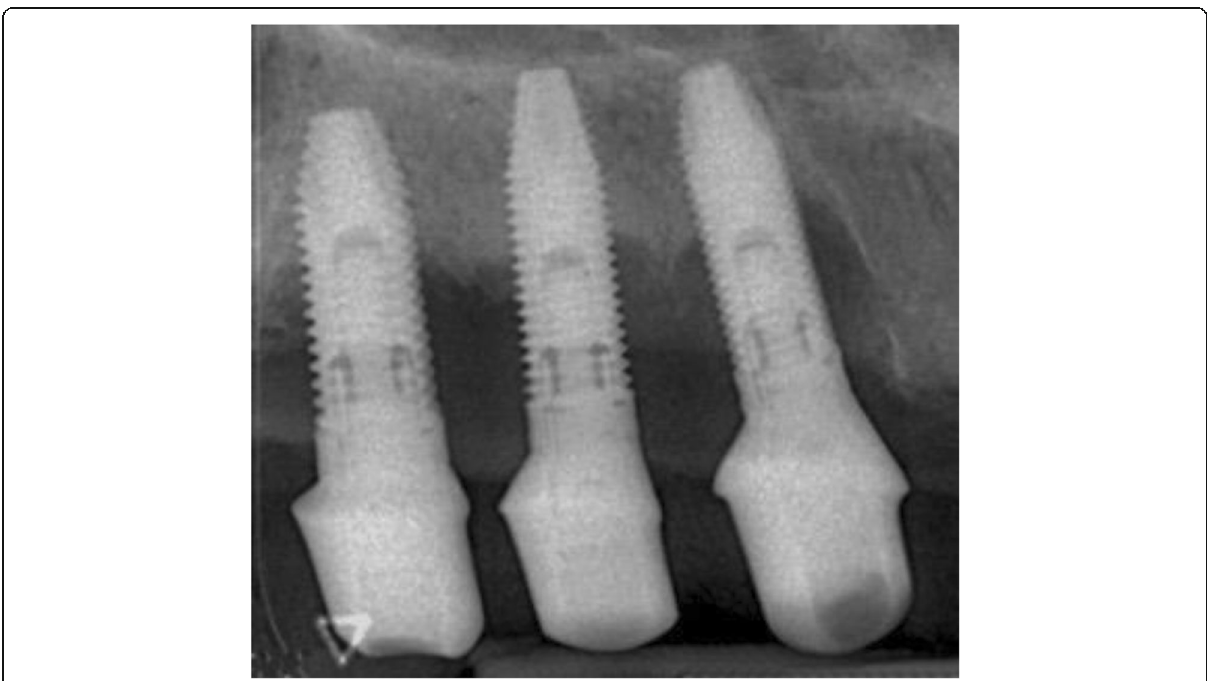
Fig. 9 The intraoral radiographs 16 years after insertion of the superstructure showed horizontal and vertical bone loss up to the 10th thread at all implants